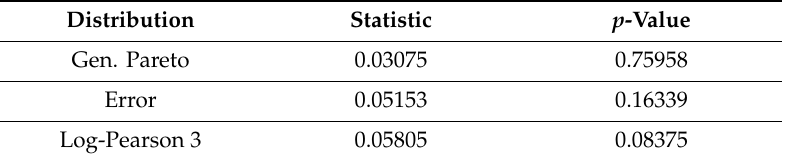
Table 7. Test statistical values for the best fitted three-parameter distributions.